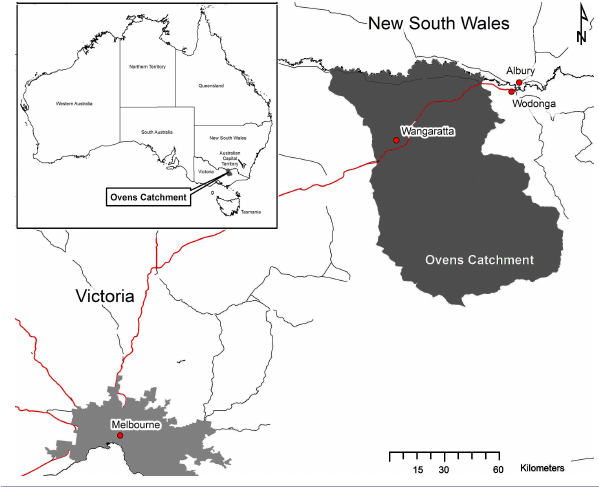
Fig. 2 . Map of Ovens catchment, Victoria, Australia. The red line is the Hume Freeway that links Melbourne and